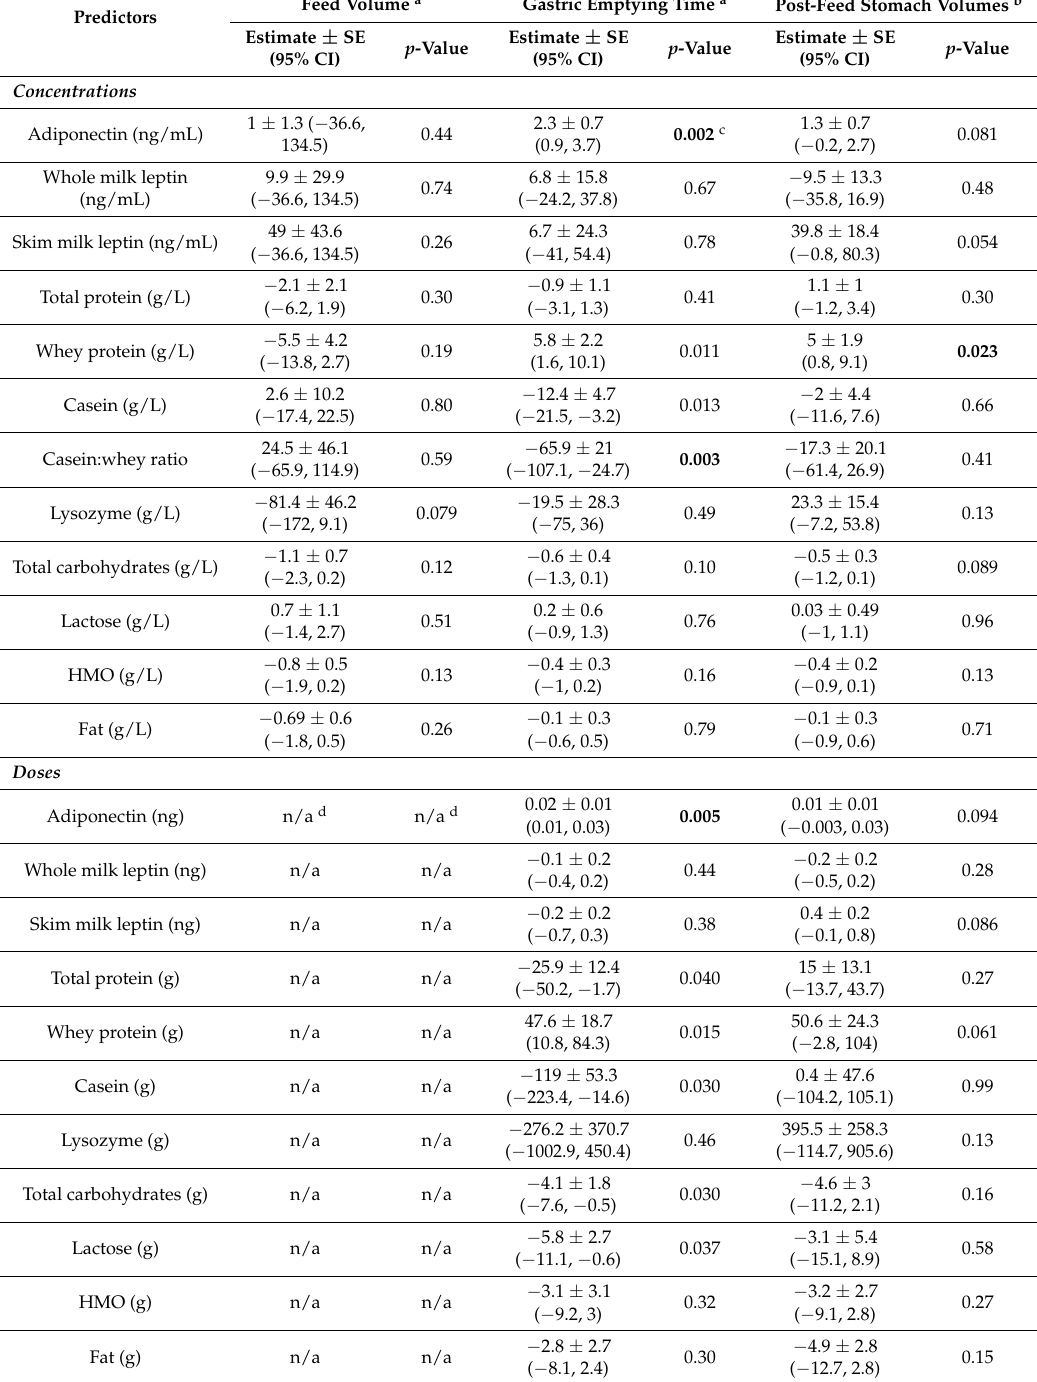
Table 3. HM components and infant characteristics and their associations with feed variables and gastric